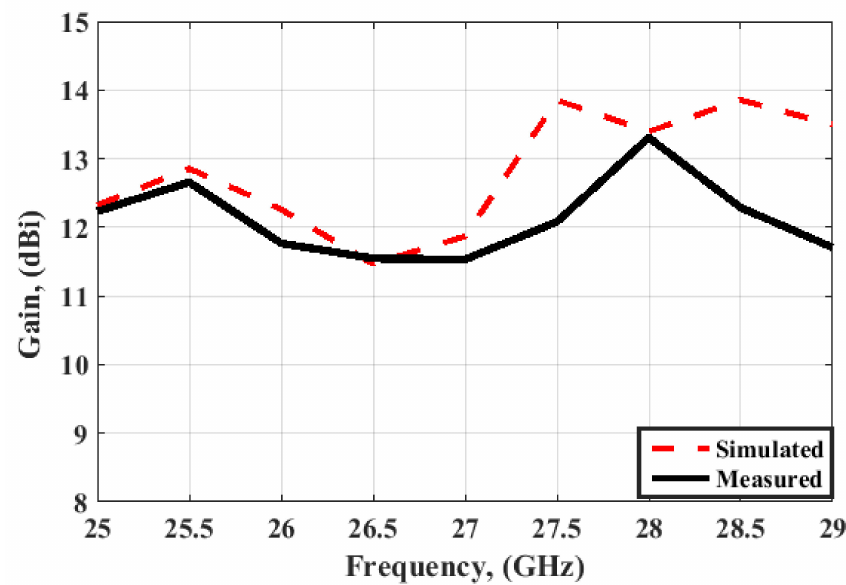
Figure 16. Gain variation versus frequency of the antenna with AMC.